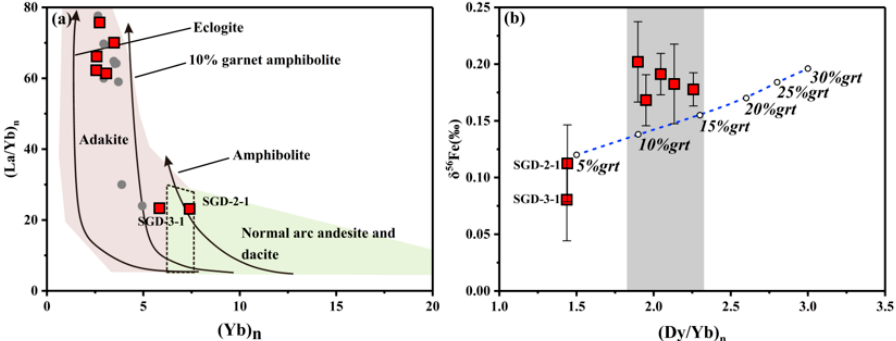
Figure 9. ( a ) (Yb) n vs. (La/Yb) n [48], ( b ) (Dy/Yb) n vs. δ 56 Fe. The percentage denotes the content of garnet within the assumed source rock, and the blue dotted line is based on the simulative results from [14].